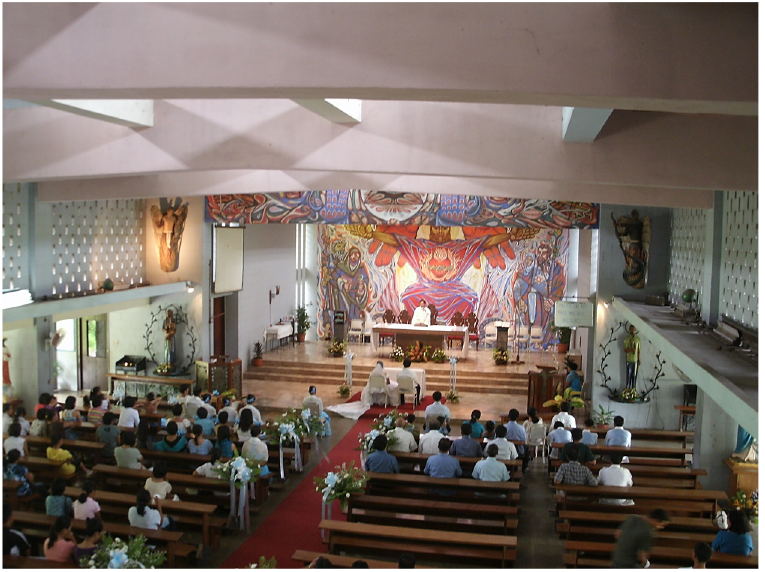
Figure 14. View of the day-lit interior of the church with registers of 400 lux, under the tower, at the time of the photograph (July, 12 h). time of the photograph (July, 12